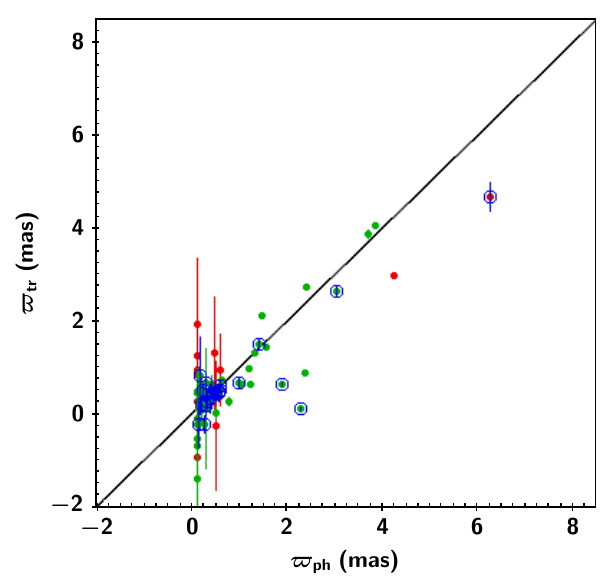
Figure 2. Photometric parallax ( (cid:118) ph ) from Paper18 and trigonometric parallax ( (cid:118) tr ) from Gaia for all stars in common to Paper18 and Gaia DR2 that satisfy (green points) and do not satisfy (red points) the ACS requirements. Blue circles are the stars used in Paper18 for the A V ( d ) construction. “ (cid:118) tr = (cid:118) ph ” is indicated as a black line.